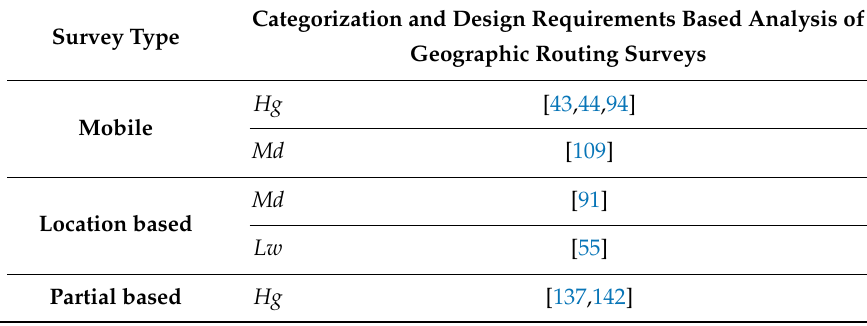
Table 11. Design analysis of geographic routing surveys in